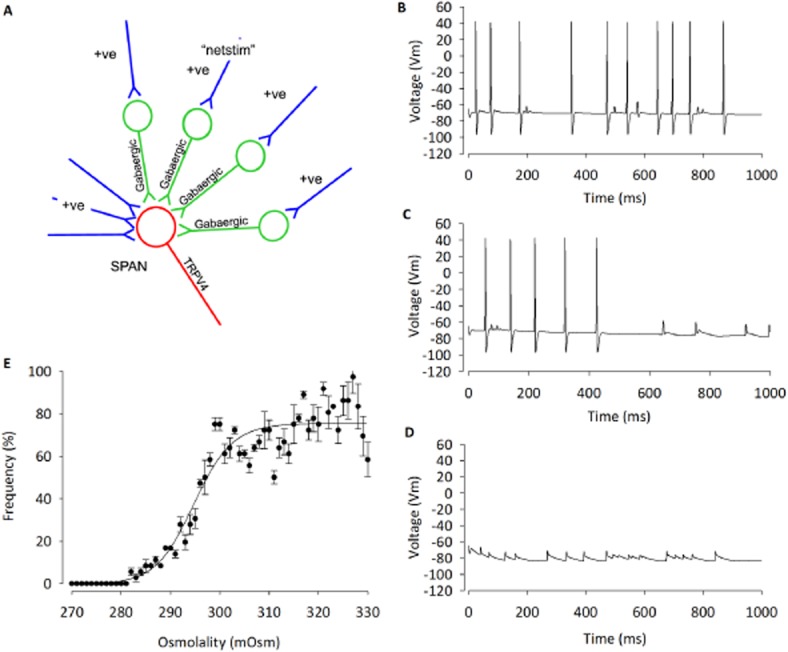
Development of a NEURON simulation based upon our hypothesis and parameters set by experimental data. (A) A computer model was developed using NEURON, which includes TRPV4 channels and allows an accumulation of Ca2+ into the cell. This is then linked to a KCa channel. Within the model, we can change osmolality and also block Ca2+ conductance. (B) Action potentials during hypertonic conditions (320 mOsm). (C) Decrease in action potential frequency when osmolality is reduced to 300 mOsm, and (D) further decreased action potential frequency at 270 mOsm. (E) Dose–response curve during changes in osmolality within the model.